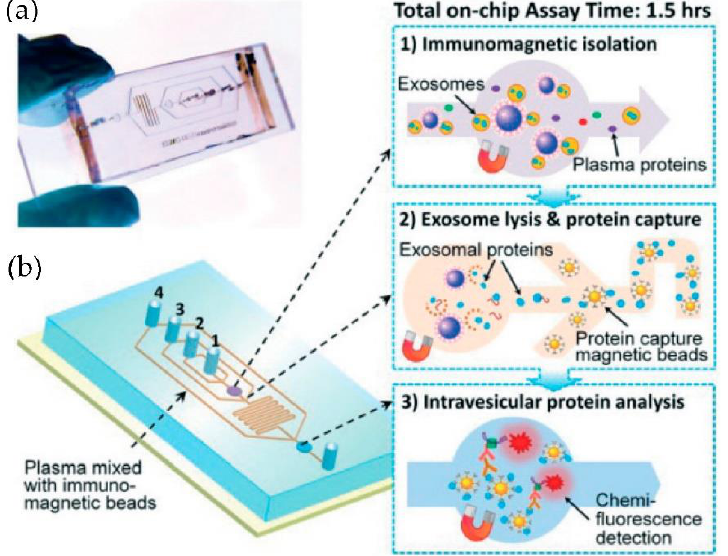
Figure 10. Integrated microfluidic exosome analysis directly from human plasma. ( a ) A photo of the prototype chip with the cascading microchannel for multi-stage exosome capture and analysis. ( b ) Schematic of the chip with the workflow. The numbers 1 – 4 indicate the inlet for exosome capture beads, washing/lysis buffer, protein capture beads, and ELISA reagents. (Reproduced from He M. et al. [75]. Copyright 2014, Lab Chip).